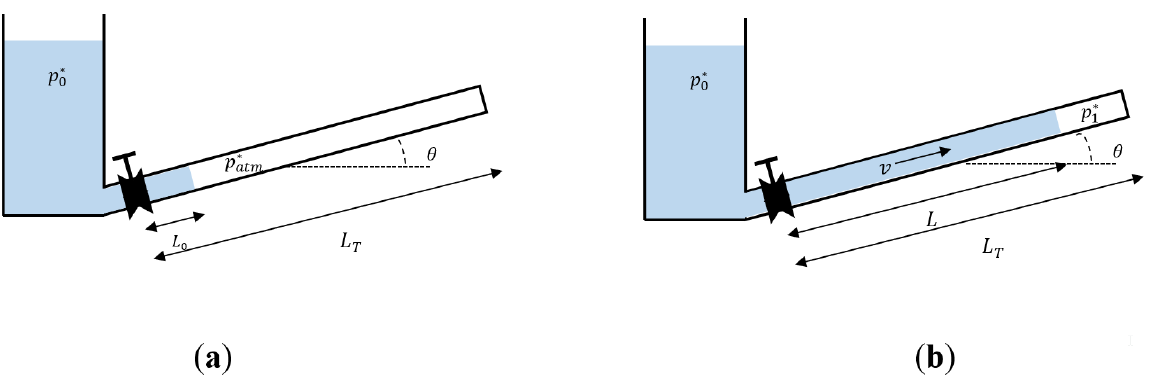
Figure 1. A filling process configuration: ( a ) hydraulic system at rest ( t = 0); and ( b ) hydraulic system at 𝑡 ≠ 0 .